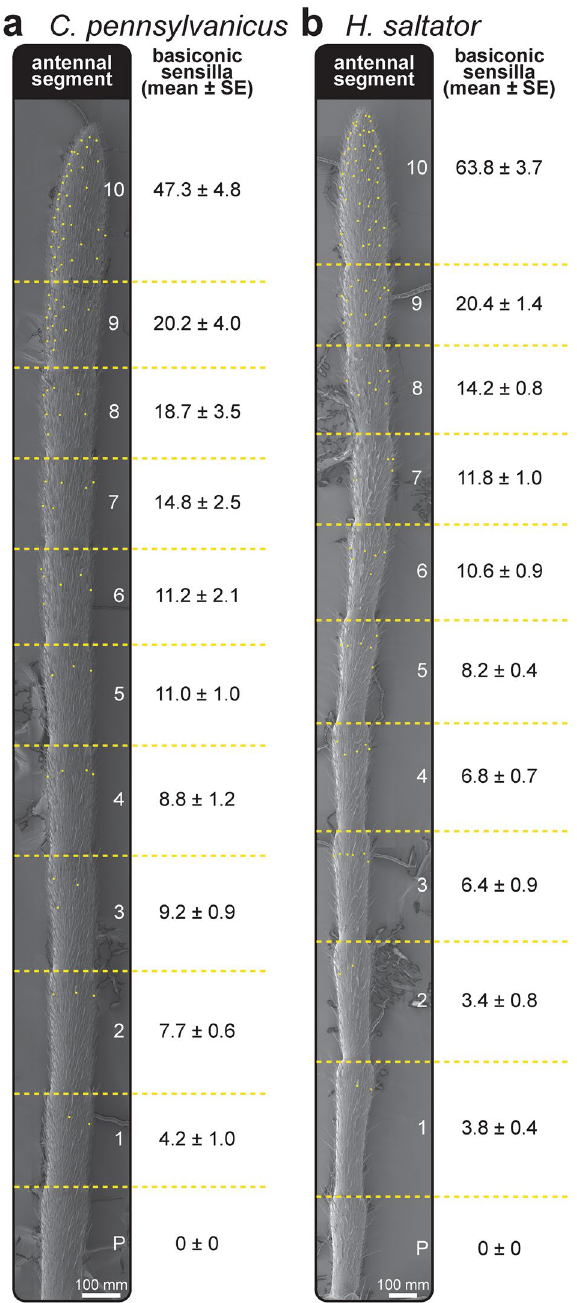
Figure 2. Distal abundance of basiconic sensilla across two distantly related ant species. Images of the funiculus segments (1–10) and pedicel (P) (left) and basiconic sensilla counts (right) of a C. pennsylvanicus minor worker ( a ) and H. saltator worker ( b ). Yellow dots denote the position and overall distribution of basiconic sensilla. Sensillum counts represent the average and standard error of the dorsal and ventral total per individual ( n =